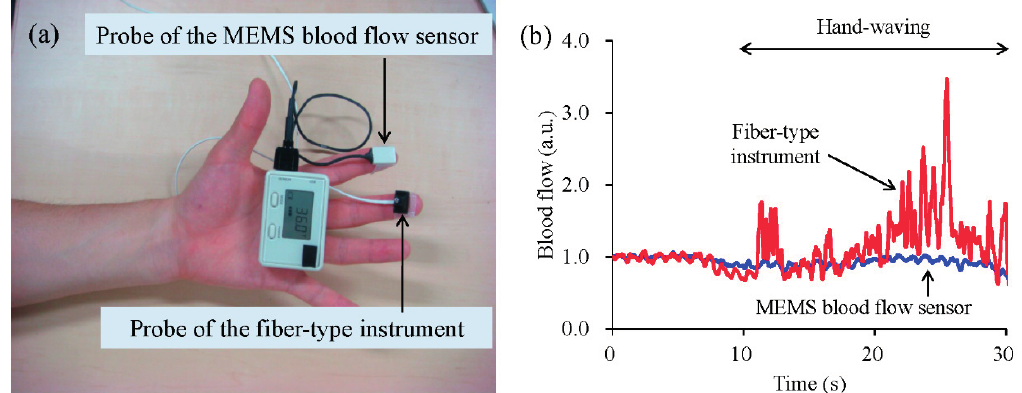
Figure 2. Comparison of blood flow signals between the MEMS blood flow sensor and a conventional optic fiber-type instrument [25]. A photograph of the probes from the MEMS blood flow sensor and an optic fiber-type instrument attached at the second and third fingertips, respectively ( a ); The blood flow signal patterns during hand waving are shown for each device ( b ). Hand waving was begun 10 s after the start of